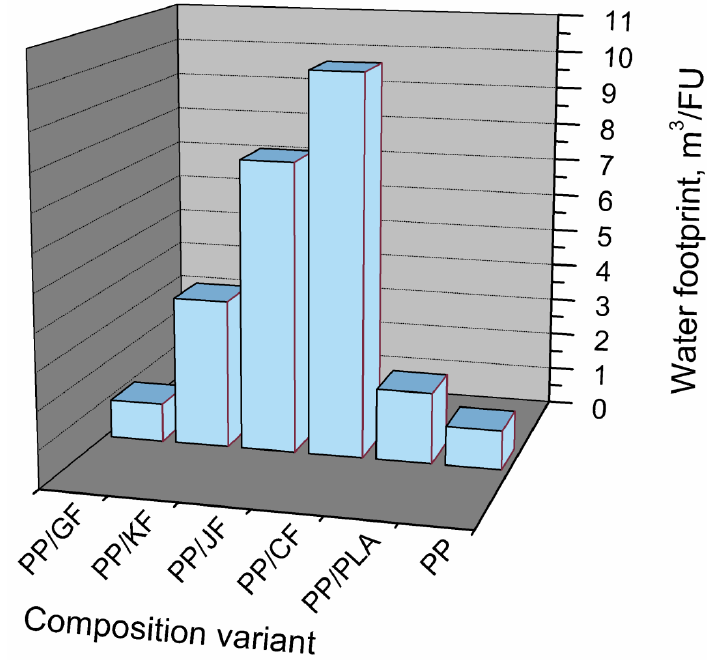
Figure 4. Water footprint for different composition variants of EUR-pallet.